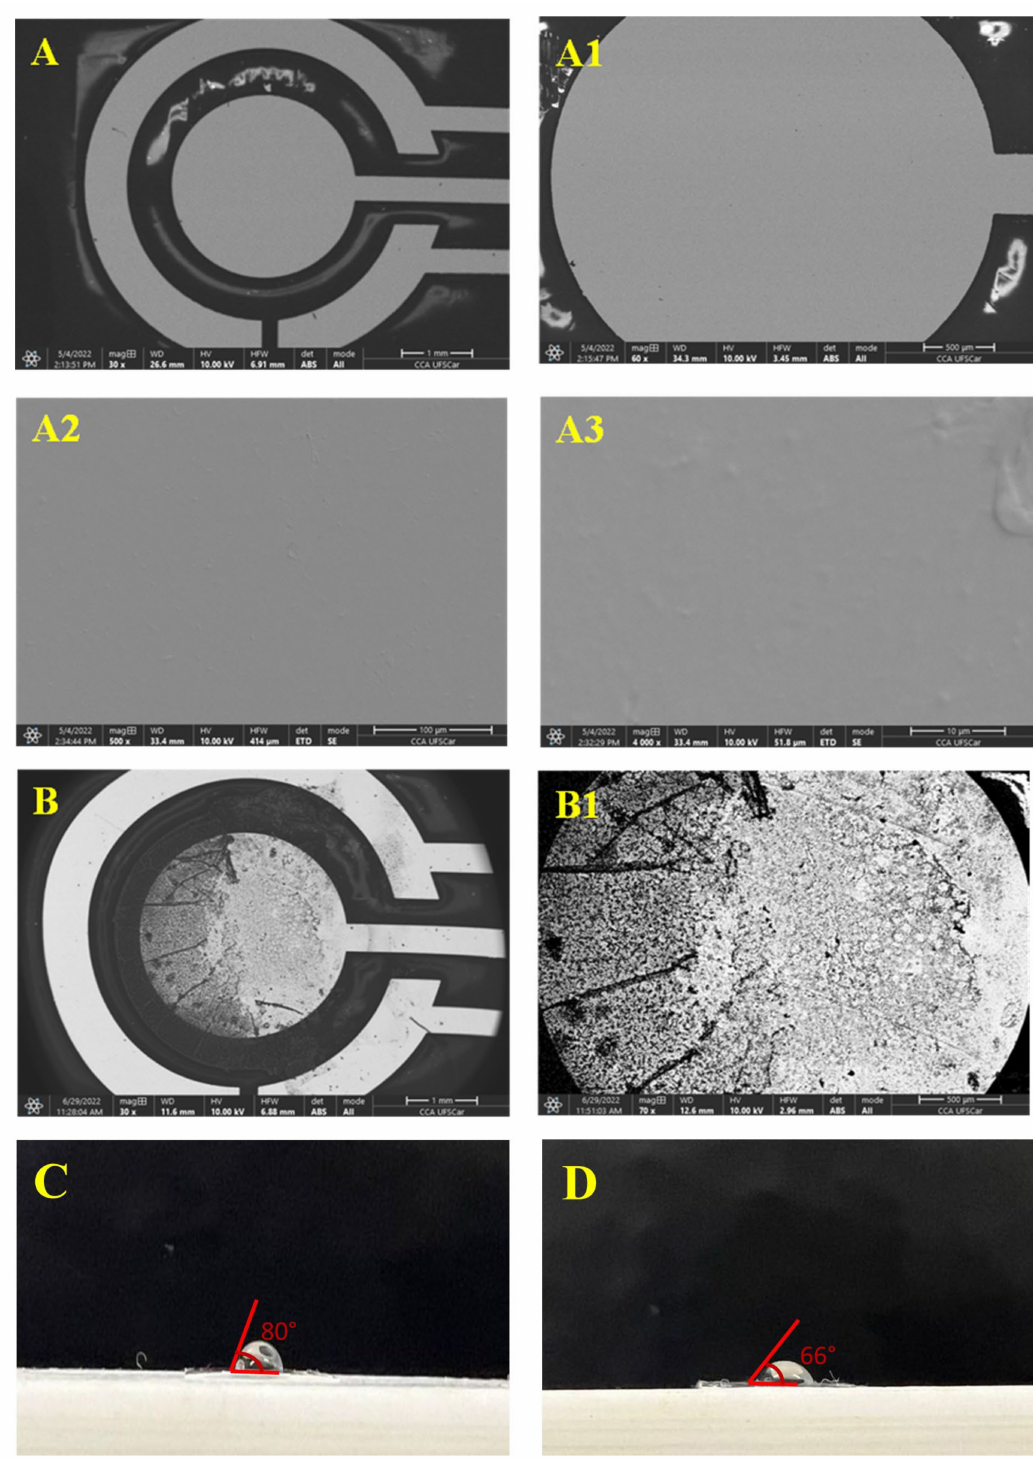
Figure 2. ( A ) SEM images of the platinum working electrode at different magnifications: 30 × ( A ), 60 × ( A1 ), 500 × (A2) and 4000 × ( A3 ), respectively. ( B ) SEM images of the modified platinum working electrode at different magnifications: 30 × ( B ) and 60 × ( B1 ), respectively. Water contact angle images obtained for the electrodes ( C ) before and ( D ) after the